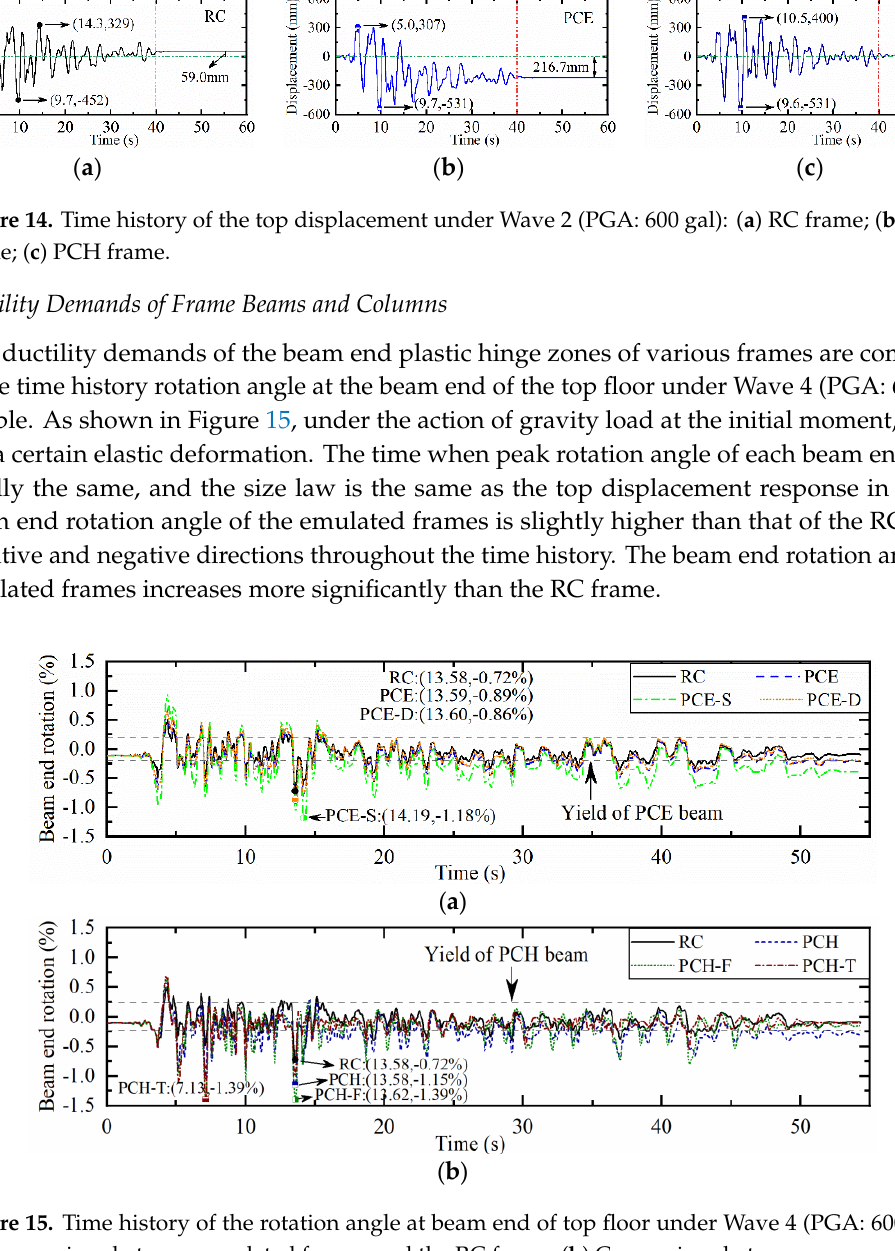
peak displacement of PCE frame is significantly higher than that of the RC frame. In addition to the